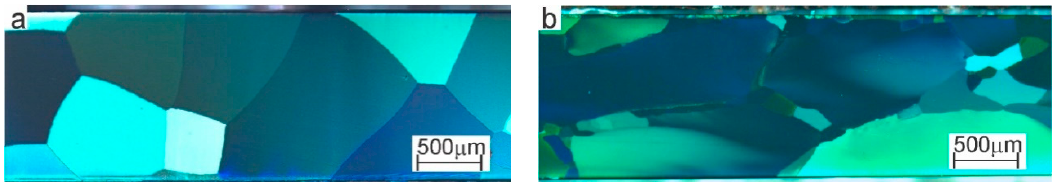
Figure 1. Initial microstructures of the starting materials under crossed polarisers. Grain size is very large. ( a ) As-cast (AC) material. ( b ) Hot rolled (HR) material; brightness variation in the HR-material is due to strain-induced optical anisotropy.